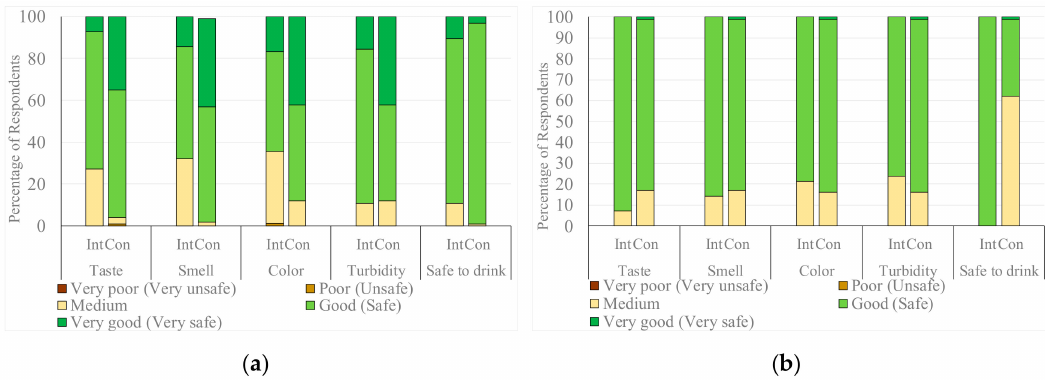
Figure 3. Perception of quality and safety of main source of drinking water in: ( a ) pre-intervention period and ( b ) post-intervention period. Int = Intervention site and Con = Control